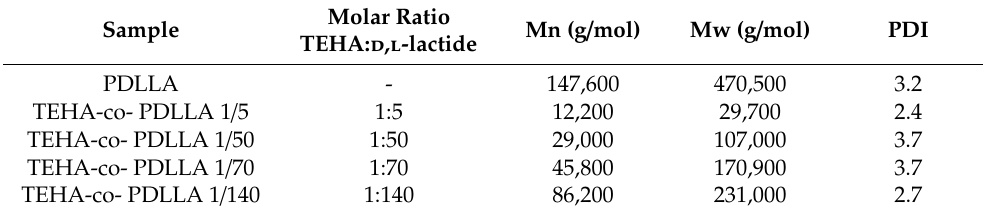
Table 1. Molar masses of neat PDLLA and TEHA-co-PDLLA semitelechelic block copolymers.